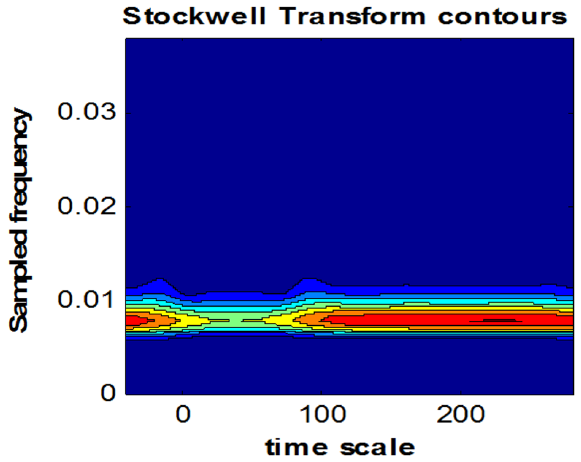
Fig. 6. Stockwell Transform (ST) contours